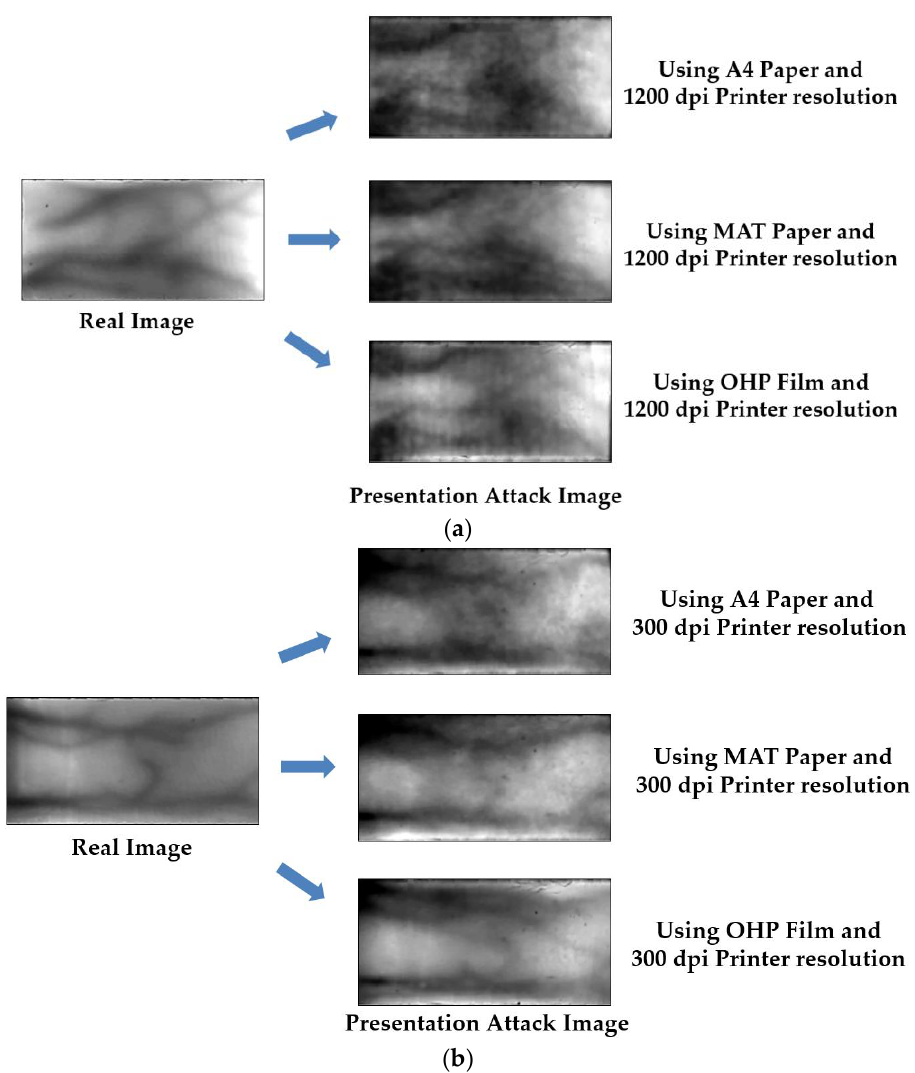
Figure 4. Examples of real and presentation attack finger-vein images in ISPR database: ( a ) using 1200 dpi printer resolution; and ( b ) using 300 dpi printer resolution.